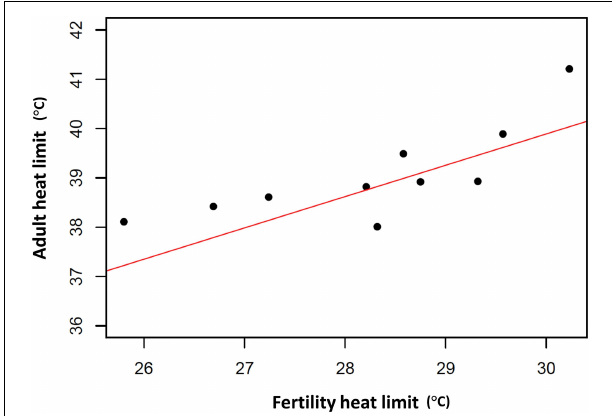
FIGURE 3 | Association between adult critical thermal maximum (CTmax) and male fertility thermal limits (FTL50) among 10 Drosophila species. Red line represents the fitted phylogenetic generalized least squares (PGLS) model fitted using the R package nlme ( R 2 = 0.59, t = 5.59, d.f. = 10, p < 0.001). CTmax and FTL50 data from van Heerwaarden and Sgrò (2021). Phylogenetic information from Finet et al. (2021).